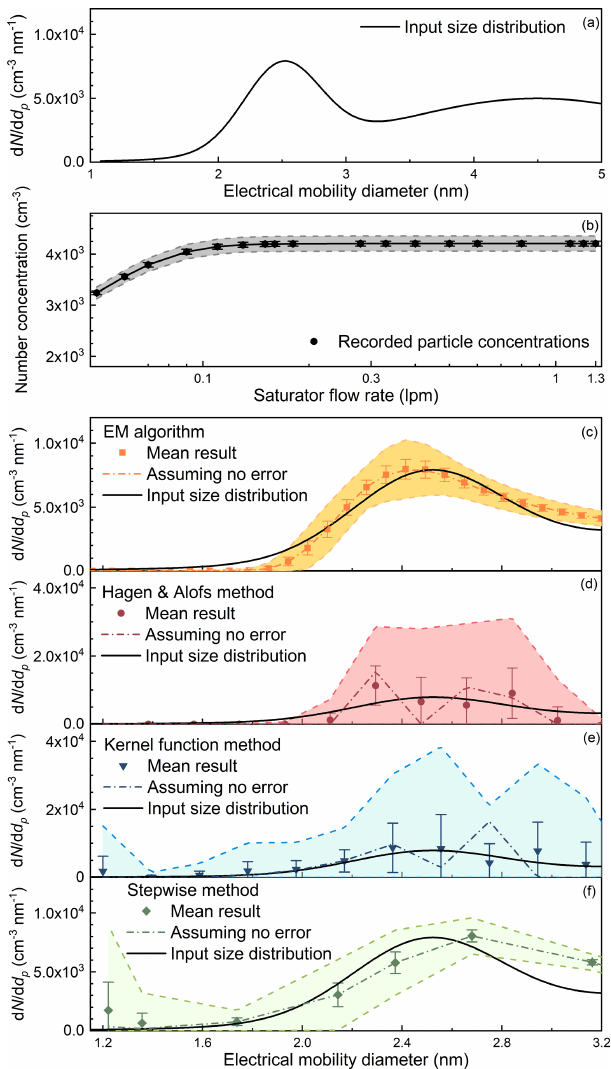
Figure 7. The input and recovered sub-3nm particle size distribu- tions simulated using the Monte Carlo method. Note the vertical axes in panels (c) – (f) are not the same.